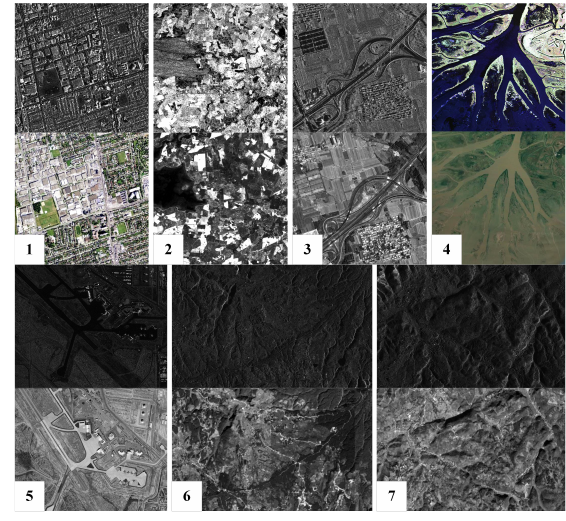
Figure 3 . SAR-optical